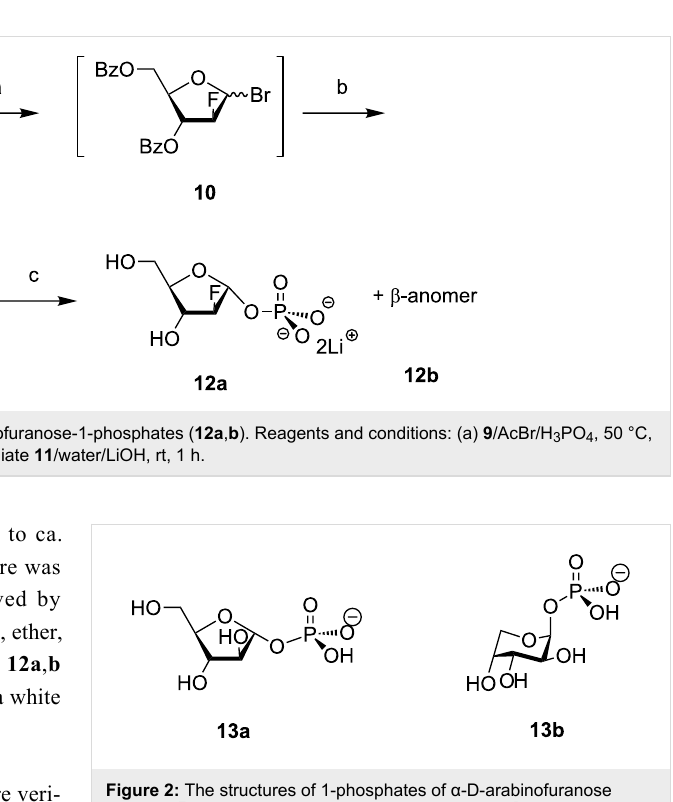
the α -anomer 12a . The slightly more stable conformation (C-3- exo conformer; E T = − 732311.2 kcal/mol) is stabilized by the intramolecular C-3OH··· − OP (1.68 Å) hydrogen bond and the close proximity of the C-5OH hydrogen and FC-2 fluorine atoms (C-5OH···FC-2 1.98 Å). The other structure (C-3- exo conformer; E T = − 732310.1 kcal/mol) does not contain the intramolecular hydrogen bonds. The torsion angles of the vicinal hydrogen atoms H-1/H-2 and H-2/H-3, the hydrogen–fluorine (H-1/F and H-3/F) and hydrogen–phos- phorus (H-1/P), and the carbon–fluorine (C-4/F) and carbon–phosphorus (C-2/P) atoms are in satisfactory agreement with the experimental coupling constants. On the other hand, the vicinal torsion H-3/H-4 angles (79° and 91°) are not in accordance with the relevant coupling constant (5.40